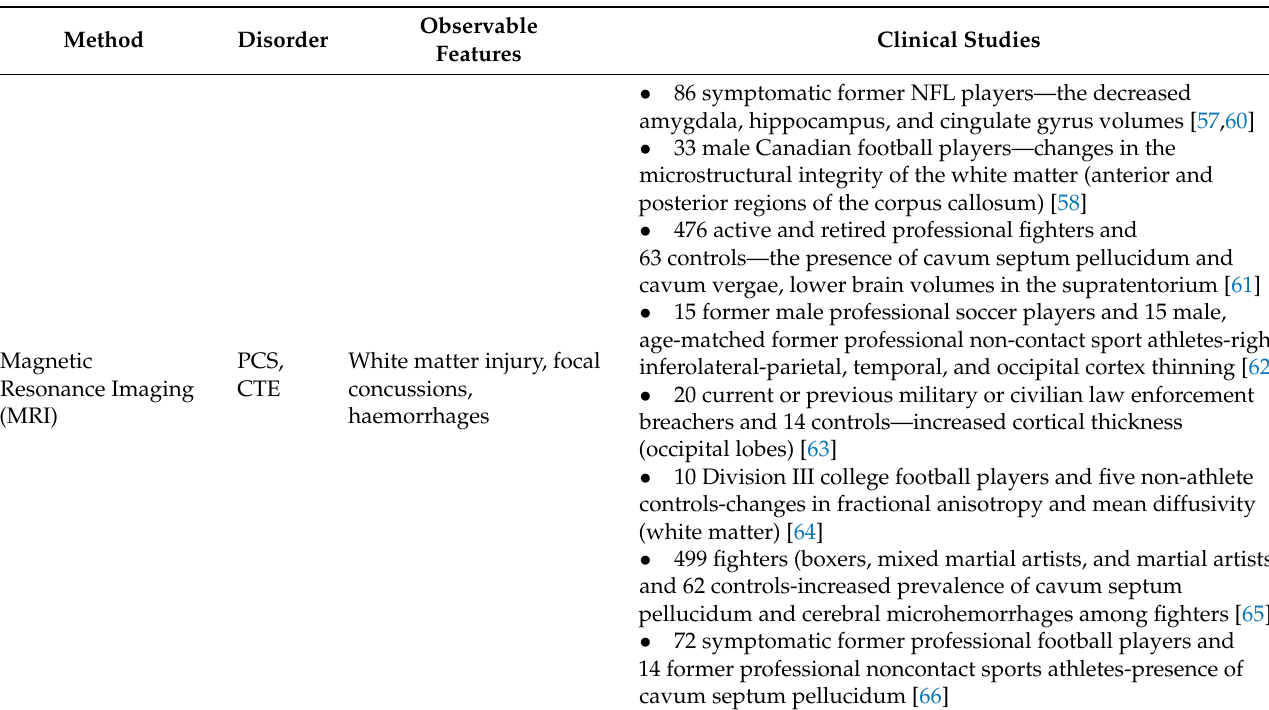
Table 2. Neuroimaging biomarkers for traumatic brain injury following repeated head impacts in PCS and